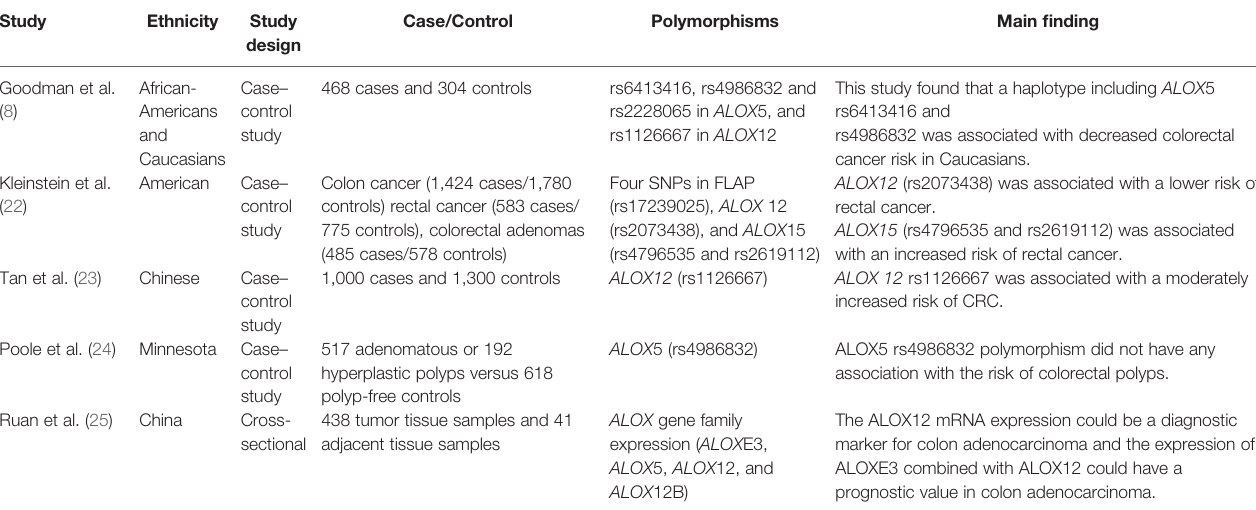
TABLE 1 | Summary of the studies related to ALOX gene polymorphisms and CRC risk.